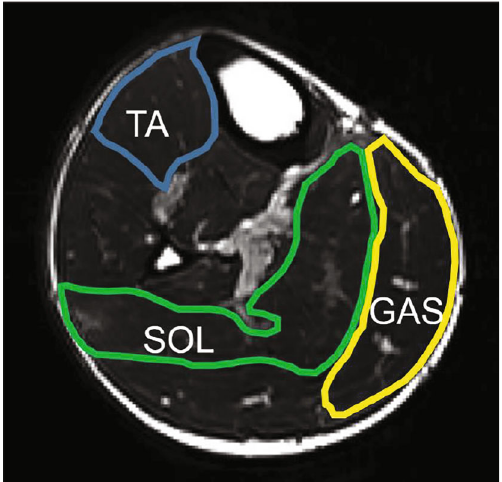
Figure 2: Methods for measuring the ROIs. The ROIs of the tibialis anterior muscle (blue square), soleus muscle (green square), and medial head of gastrocnemius muscle (yellow square) on a T2- weighted image. TA: tibialis anterior muscle; SOL: soleus muscle; GAS: gastrocnemius